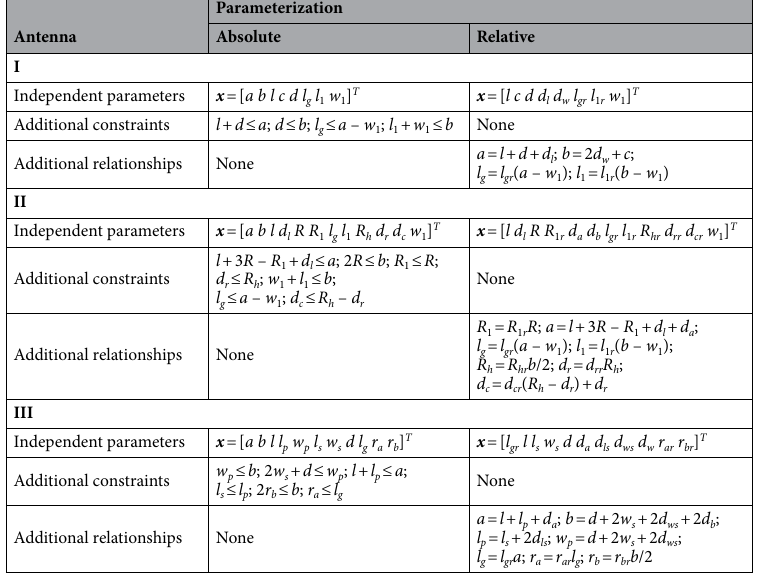
Table 3. Parameterization of Antenna I, II, and III (Fig. 2).